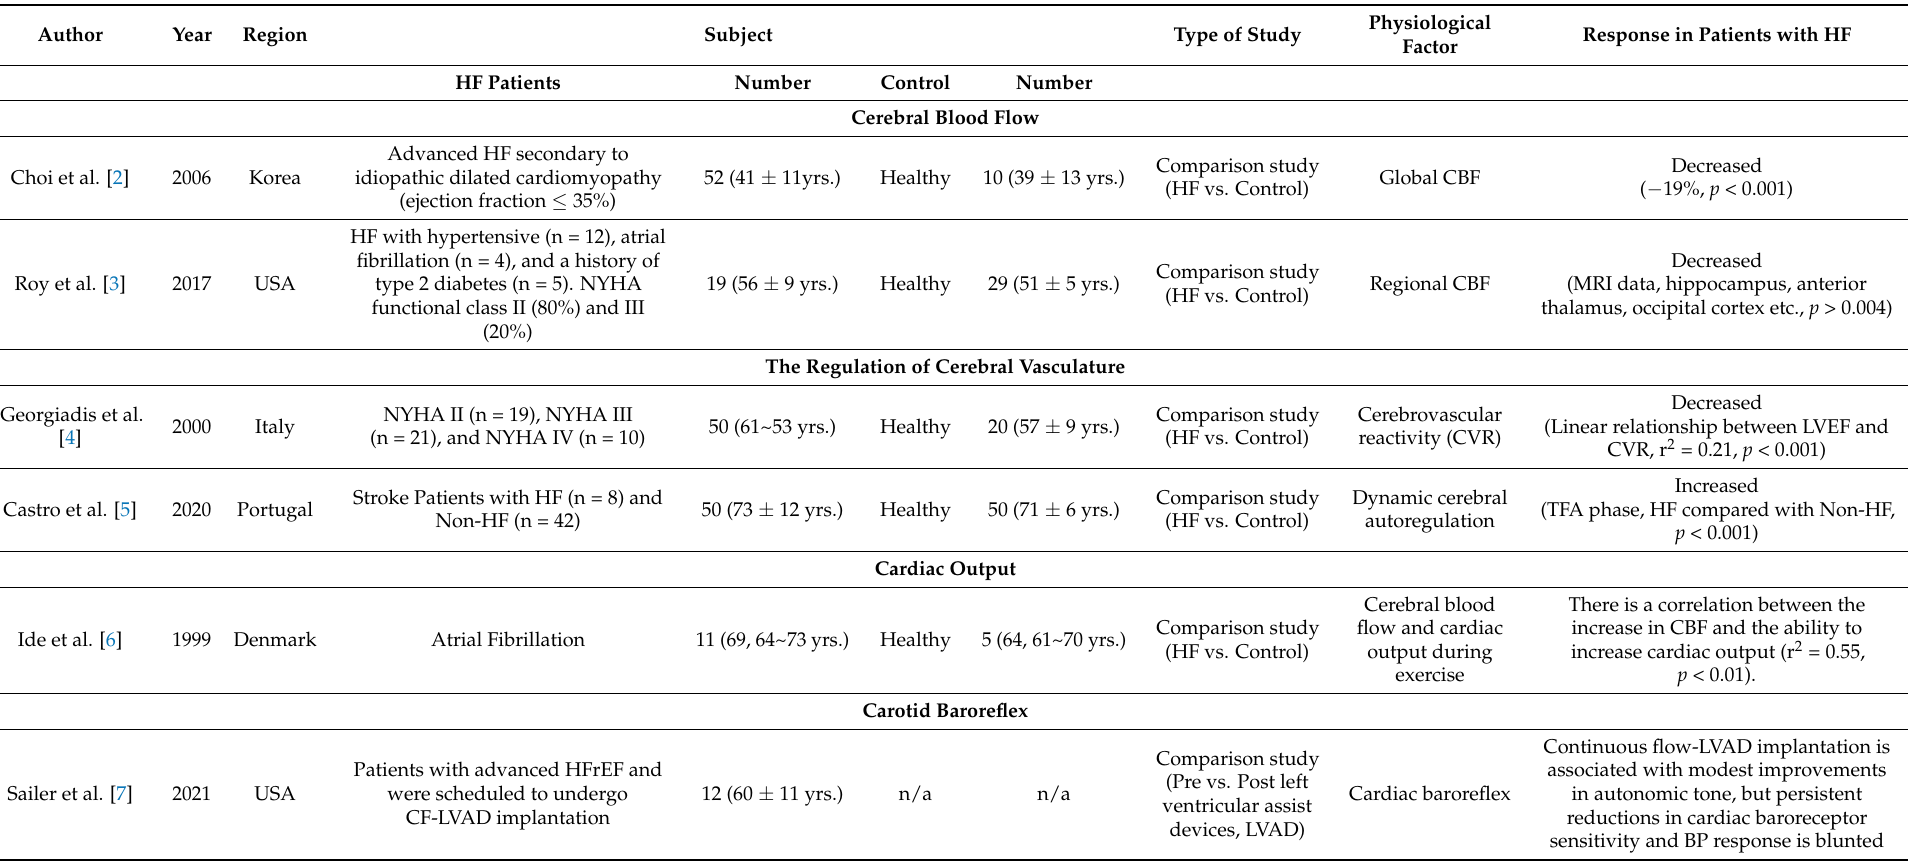
Table 1. Physiological factors, which as the risk of brain disease, altered in patients with Heart Failure (HF) reported in human